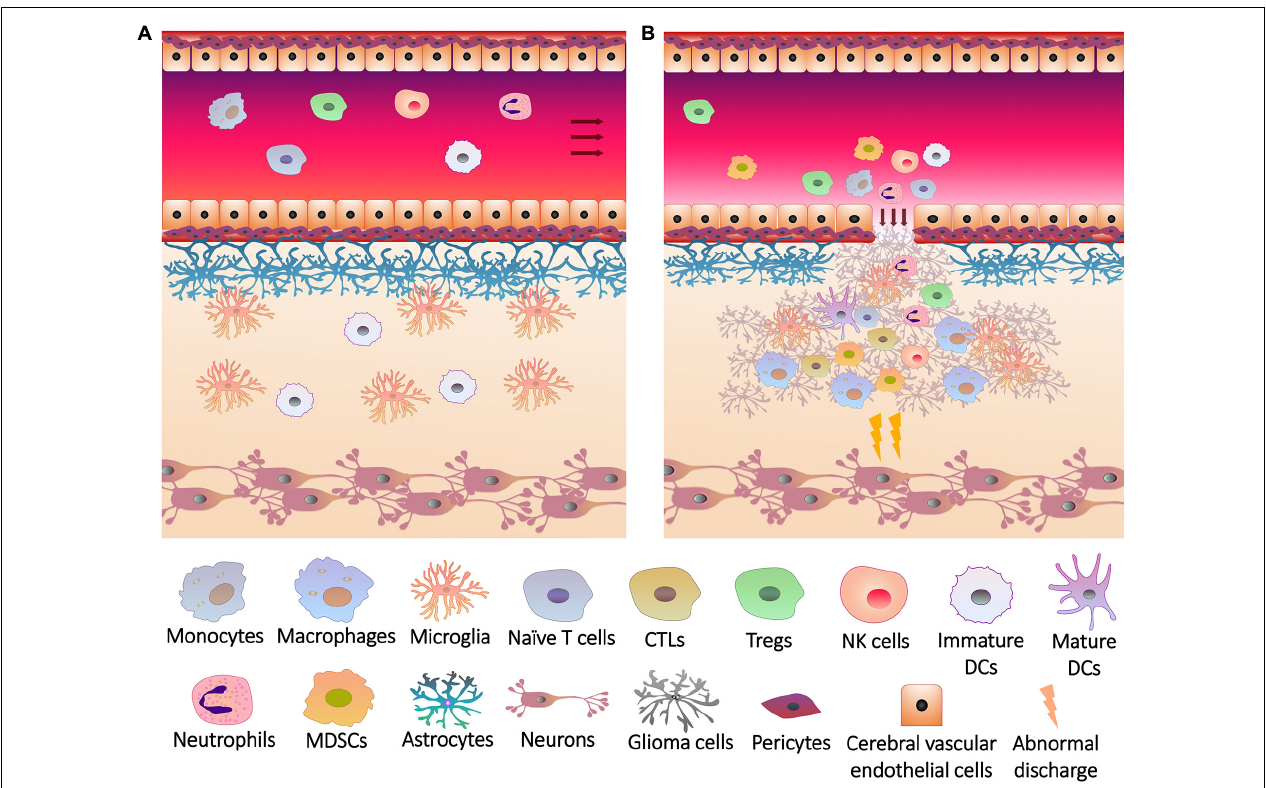
FIGURE 1 | The breakage of blood brain barrier and the infiltration of immune cells into glioma. (A) Under physiological conditions, the blood brain barrier consists of a firm multilayer barrier. Cerebral vascular endothelial cells form a tight junction structure, which is closely connected with pericytes, and is supported by basement membrane underneath. Astrocytes wrap the basement membrane through the end foot, and microglia maintain the integrity of the barrier. The immune cells originally present in the brain are mainly microglia and dendritic cells (DCs). Peripheral immune cells cannot penetrate the blood brain barrier, and brain tissues do not release recruitment signals to the cerebral blood vessels. (B) Rapid growth of glioma cells not only overexcites neurons to induce seizures, but also injures blood brain barrier. Glioma cells release chemokines and other cytokines through the cracks of blood brain barrier to induce the differentiation, expansion and recruitment of peripheral immune cells, including monocytes (in blood)/macrophages (differentiated from monocytes in brain tissue), cytotoxic T lymphocytes (CTLs), regulatory T cells (Tregs), natural killer (NK) cells, neutrophils, DCs and myeloid-derived suppressor cells (MDSCs), which infiltrate the lesions with immune cells in situ